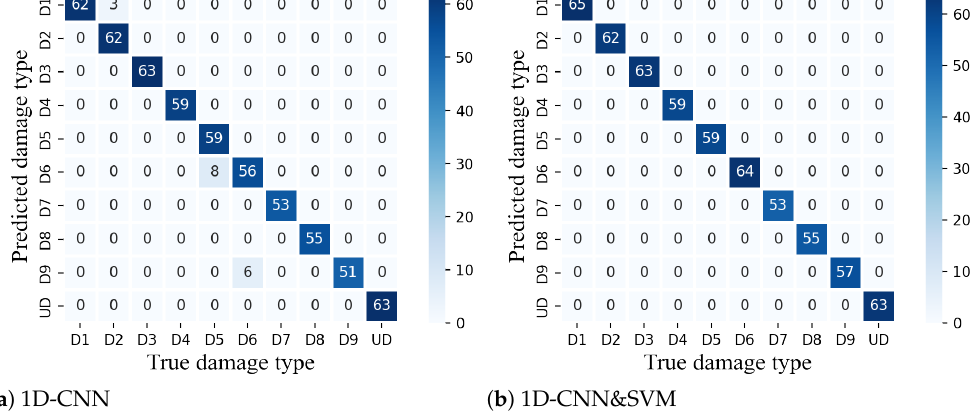
Figure 6. Confusion matrixes of 1D-CNN and 1D-CNN and SVM methods. Table 5. The time required for training and testing of the 4 methods.